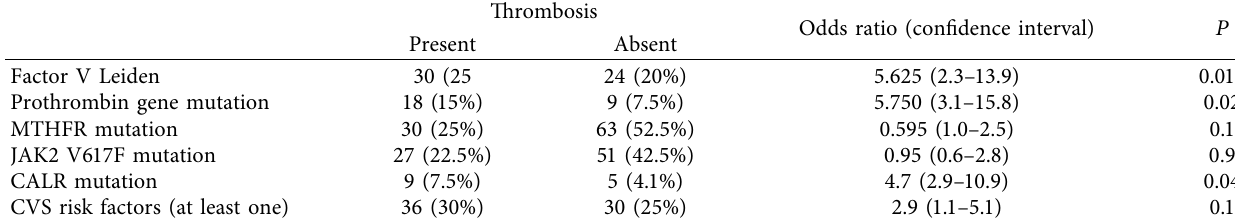
prothrombin gene, and MTHFR mutations in patients with cardiovascular risk factors versus the patients with noncardiovascular risk factors group ( P > 0 . 05) (Table 5). Six patients developed leukemic transformation during follow-up period: four of them were factor V Leiden and